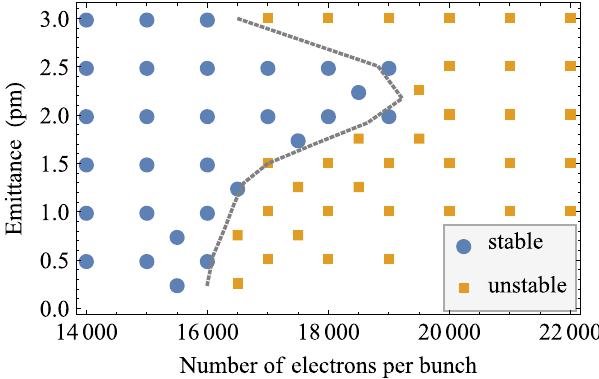
FIG. 13. Stability diagram of bunch distribution with varying transverse geometric emittance and bunch charge passing through a dual pillar APF structure with 0 . 8 μ m period length. The energy of the particles is 6.5 MeV. Simulation settings with stable behavior are colored yellow and settings with unstable behavior are colored blue. The dotted line displays the interpolated limit between stable and unstable